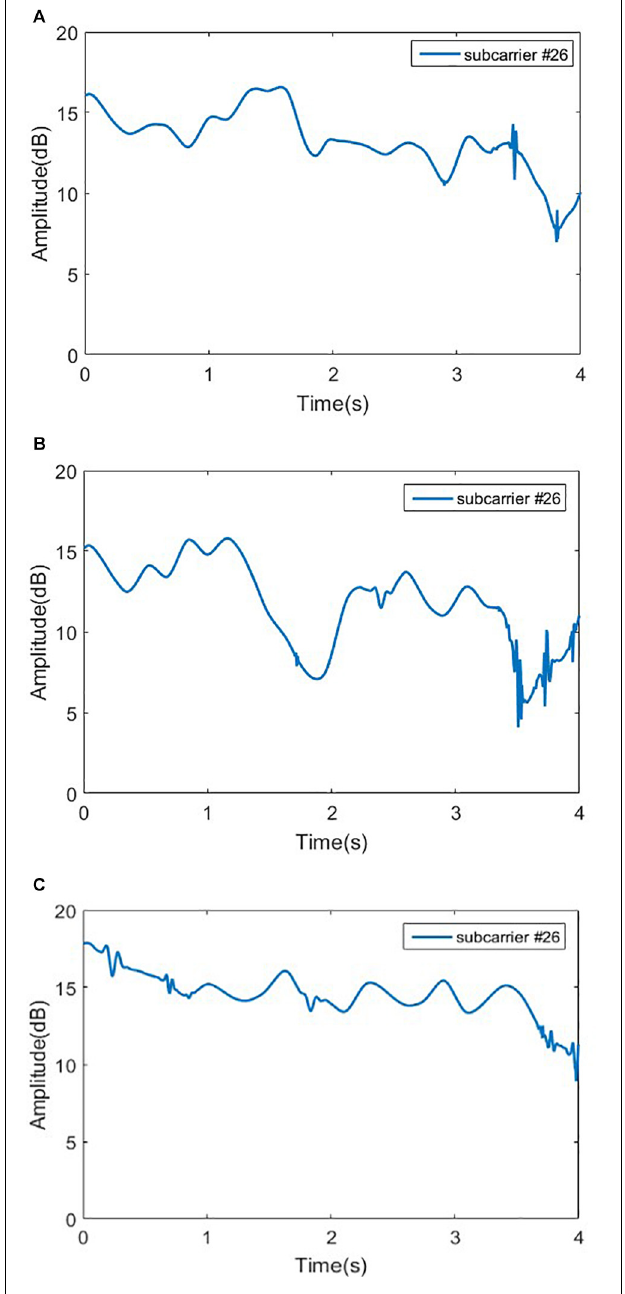
FIGURE 10 | Signal amplitudes for sensory ataxia subject, cerebellar ataxia subject and normal person in gait test. (A) Signal amplitudes for sensory ataxia subject, (B) signal amplitudes for cerebellar ataxia subject, and (C) signal amplitudes for normal